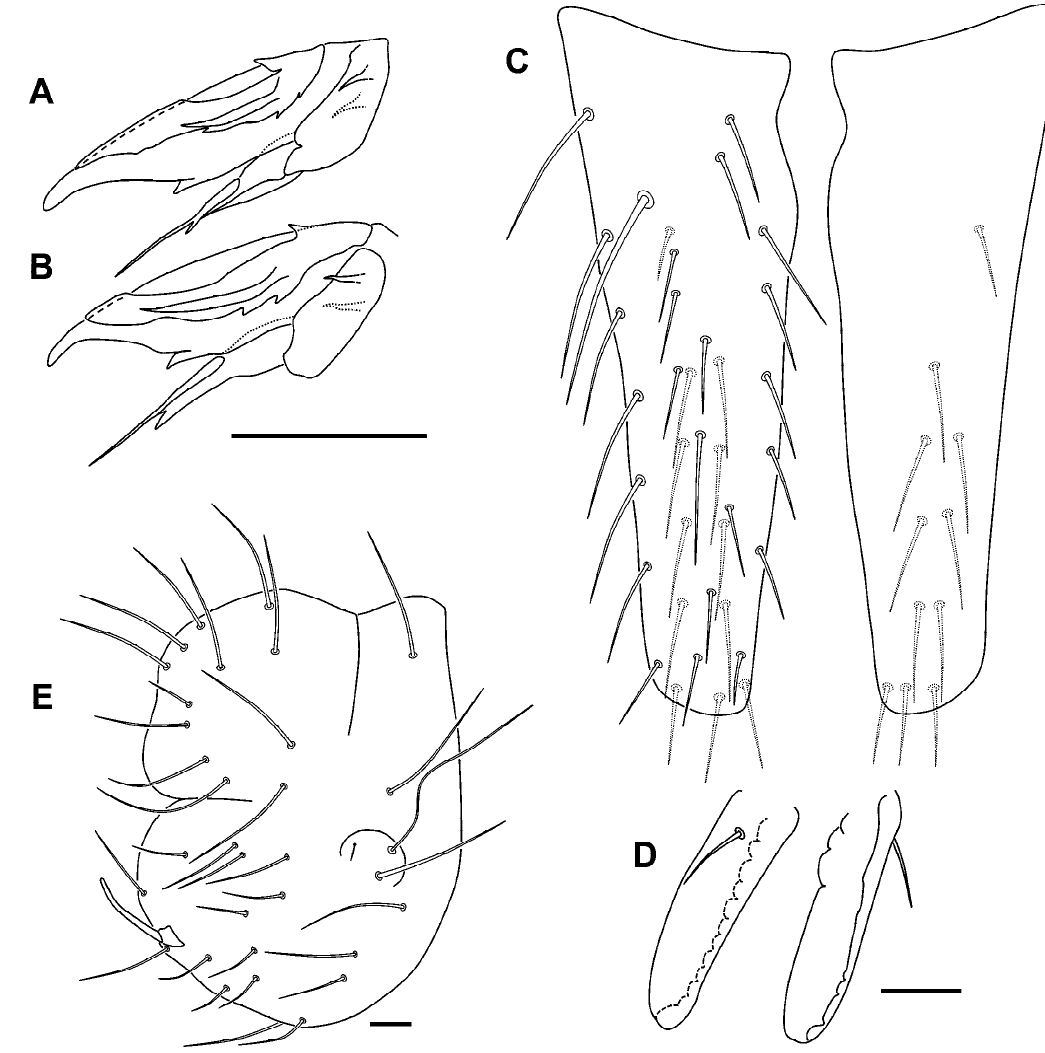
Figure 8. Allacma cryptica Baquero and Jordana sp. nov.: ( A ) claw of legs 1 and 2 (are similar), lateral view; ( B) claw of leg 3; ( C ) dens, posterior view (at right, one of the dens of the Holotype, asymmetric); ( D ) mucro, anterior view at left, posterior view at right; ( E ) female anal valves, lateral view (scale bars: all 0.05 mm).